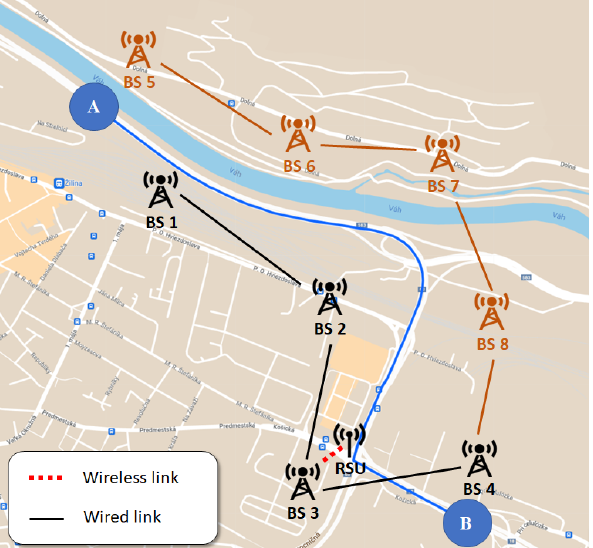
Figure 1. Visualization of the simulation scenario. Base stations depicted in black represent the cellular infrastructure used to simulate the fixed infrastructure density scenario. To study the impact of infrastructure density on the performance of Cellular-V2X (C-V2X) technologies, i.e., the varying infrastructure density scenario, four additional base stations (in red) were added.